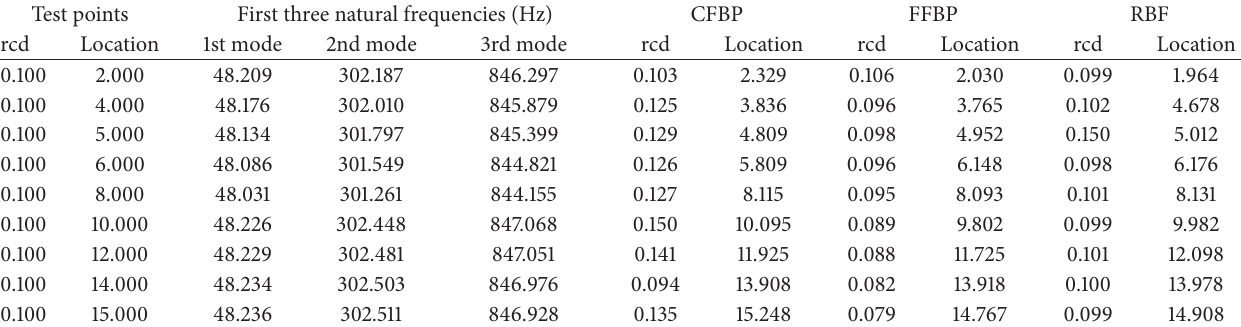
Table 4: Comparison of results among CFBP, RBF, and FFBP network.